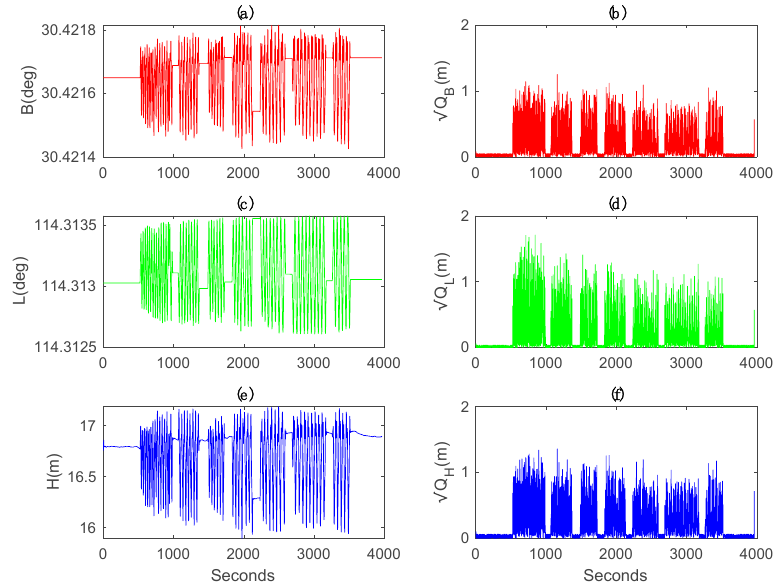
Figure 11. EM-PPP STDs w.r.t. RTK solution in Up, East and North (unit: m).